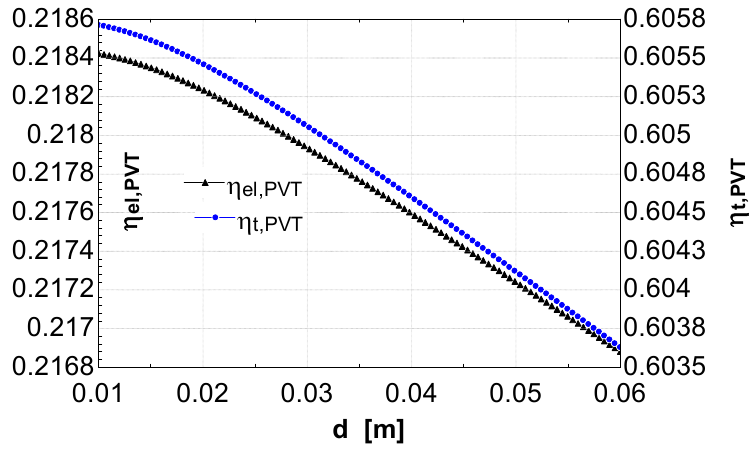
Figure 7. CPVT thermal and electrical efficiency vs. channel diameter.